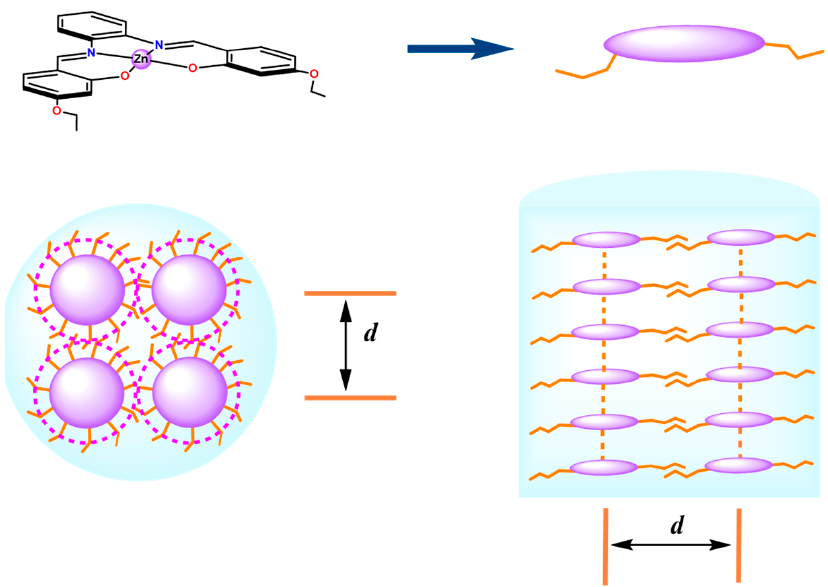
Figure 13. Sketch of nanostructures by intermolecular Zn · · · O interactions for alkoxy-substituted Zn(salphen) complexes. Cross-sectional and axial representation of nanostructures in a columnar square ( left ) or a lamellar ( right ) structure. The distance, d, can be related to the spacing derived from the XRD patterns. Adapted from Ref.